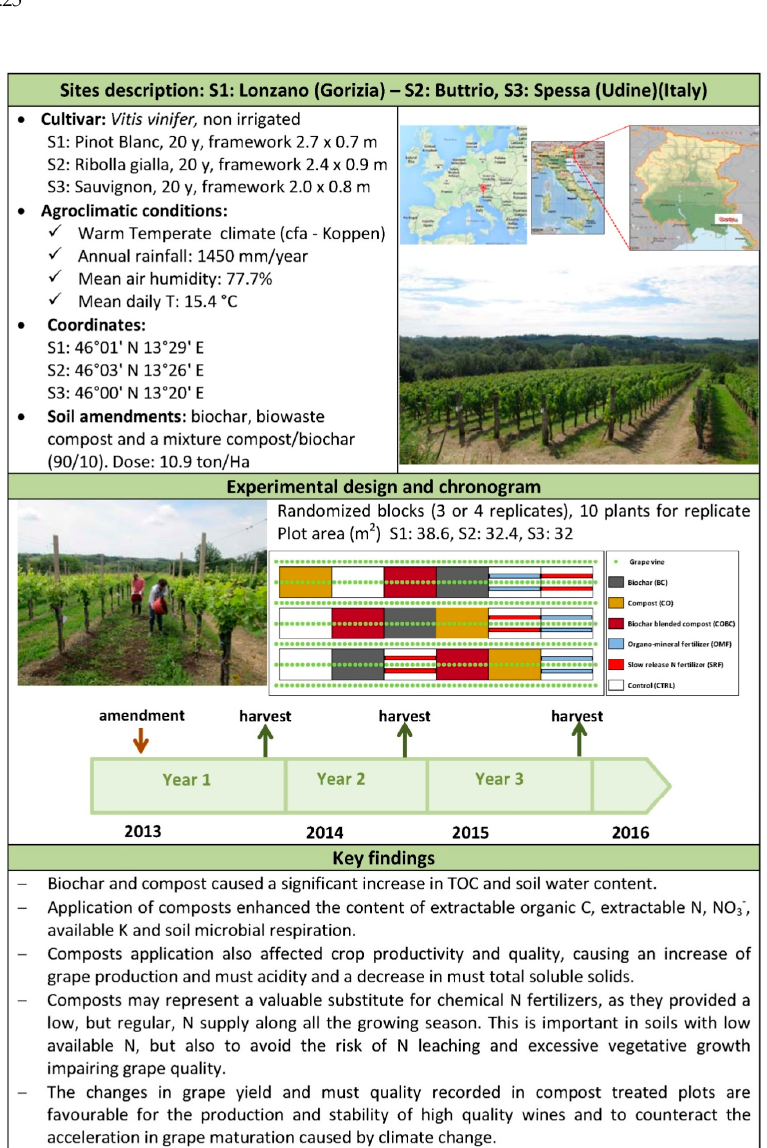
Figure 2. Description of the field scale experiment in Italy: vineyards.